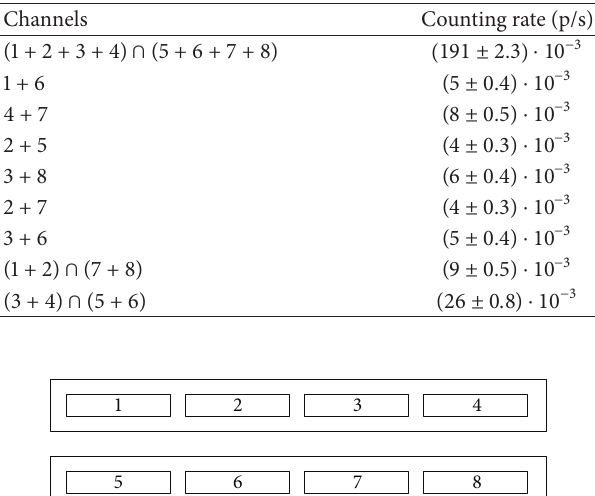
Table 3: Rate of coincidences between sheets. Measurements were performed in the Unirea mine ( − 208 m depth from surface). The acquisition time for each measurement was set to 10 hours. The coincidence is represented by “ ∩ ” sign.